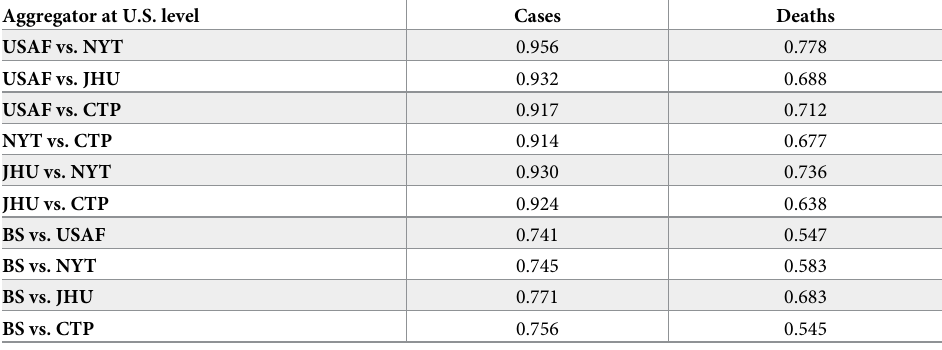
Table 3. Reliability comparisons for each pair of aggregators for cases and deaths at U.S. level. Aggregator at U.S.